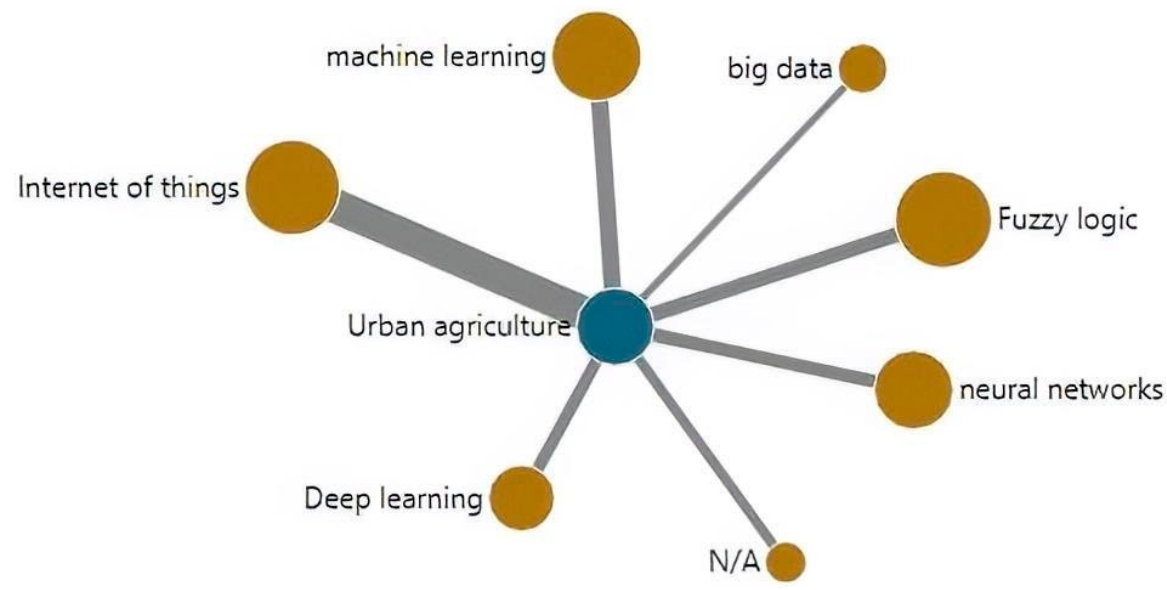
Figure 7. A nodal diagram of urban agriculture technologies. Obtained using VantagePoint.